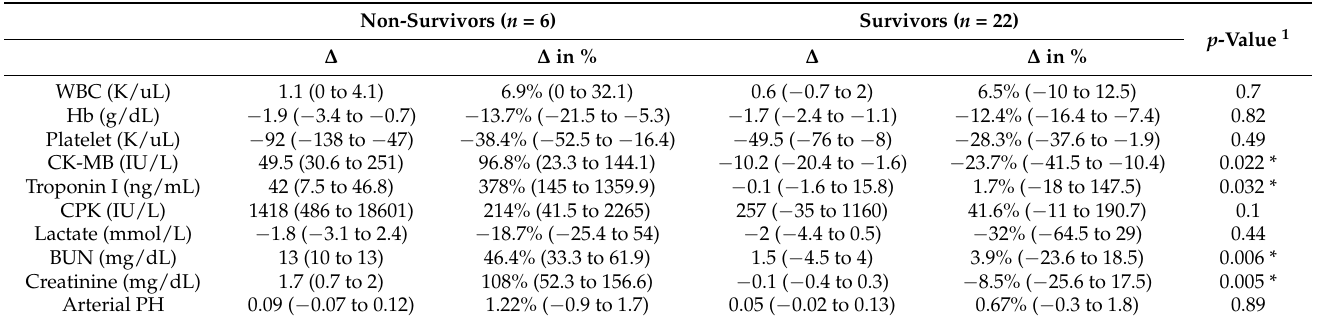
Table 3. Differences of variables within 24 h prior and after ECMO cannulation ( ∆ ).